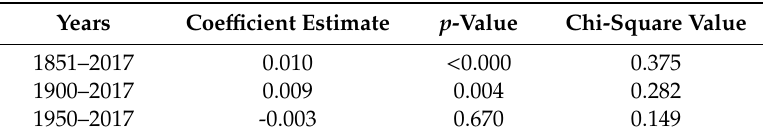
Figure 10. Incidence rate ratios of RI storms initiating RI within the Gulf of Mexico sub-basin over time described by the Poisson regression model ( a ) between 1851–2017, ( b ) depicting 1900–2017, and ( c ) 1950–2017. Table 8. Coe ffi cient estimates, p -values, and chi-square p -values on the residual deviance for RI storms initiating their first cycle of RI within the Gulf of Mexico